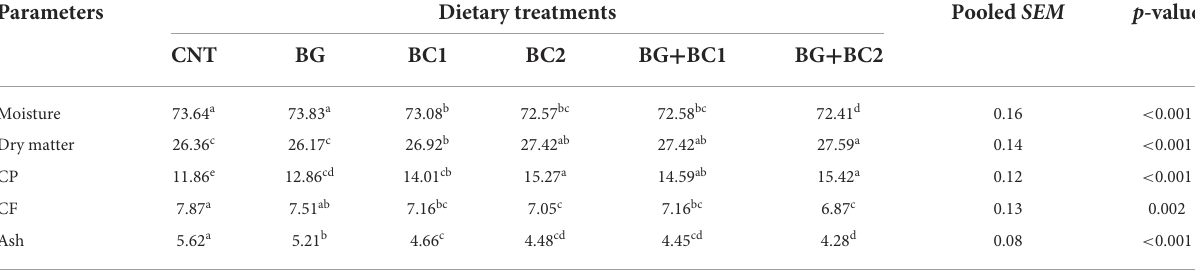
TABLE 4 Effects of dietary supplementation with β -glucan and/or Bacillus coagulans on whole body composition (% wet weight basis) of tilapia fish. Parameters Dietary treatments Pooled SEM